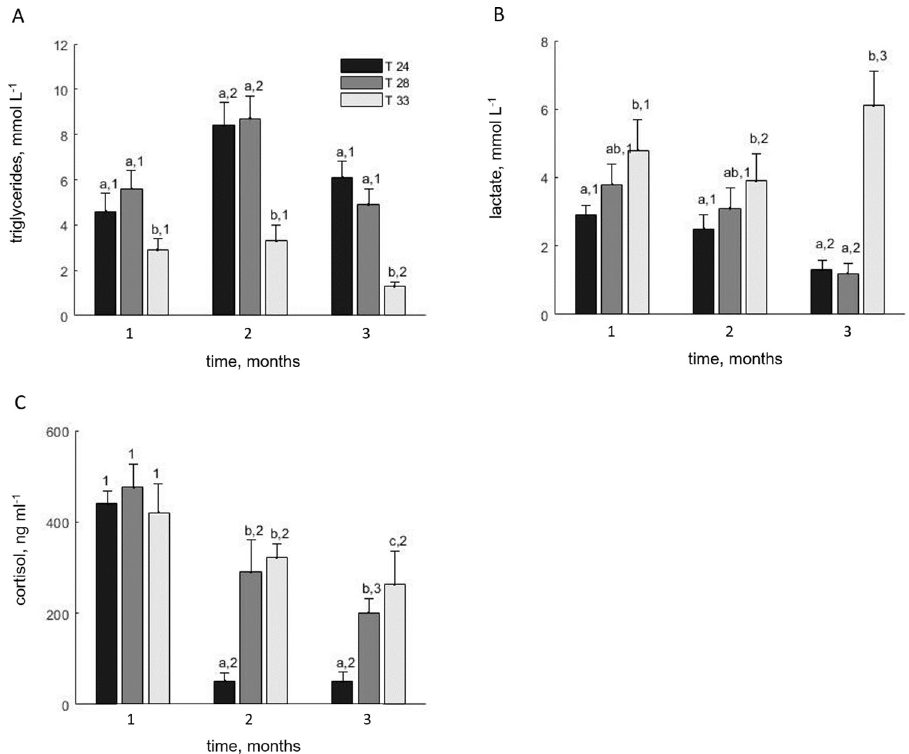
Fig 5. Plasma concentrations of triglycerides (A), lactate (B), and cortisol (C) for E. sea bass reared under three different temperatures (T-24, T-28, T-33). Values represent replicate means and the SD (3 replicates, N = 5 per replicate). Statistically significant differences between treatments in each sampling (month) are indicated with different letters and between samplings for each treatment with different